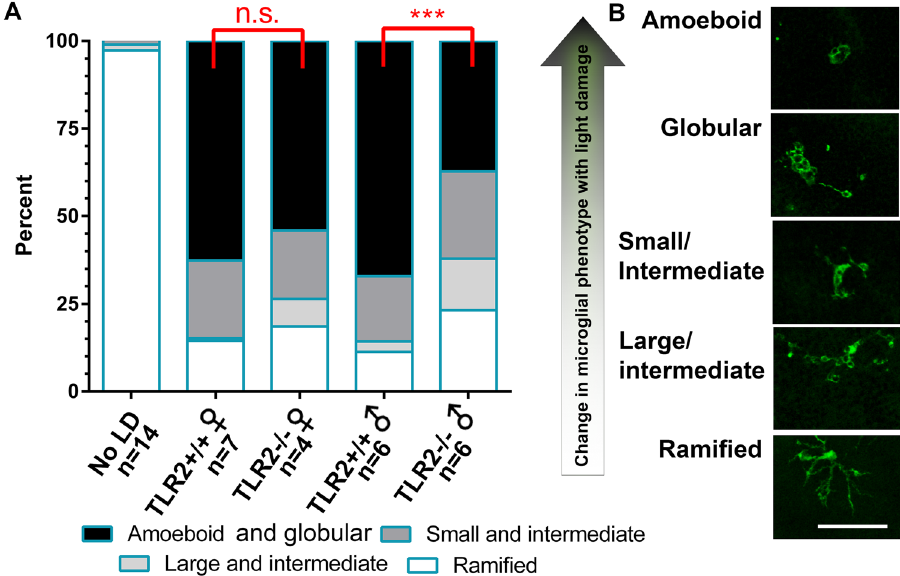
Figure 4. Microglia phenotype following light damage. Mice were exposed to light damage (LD). Eight hours following LD, flat mounts were made as described in methods, and stained with IBA1. ( A ) The proportion of microglia different activation states was calculated and plotted. ( B ) Microglia were counted from four consistent positions adjacent to the optic nerve, and sorted into categories, depending on their shape by a masked observer. n = 14 (No LD), and n = 4–7 mice exposed to light damage, combined from two independent experiments. Number of mice in specific groups is shown in the figure. Statistics: Two-way ANOVA with SIDAK post hoc test. The scale bar shown in ( B ) is 50 µ